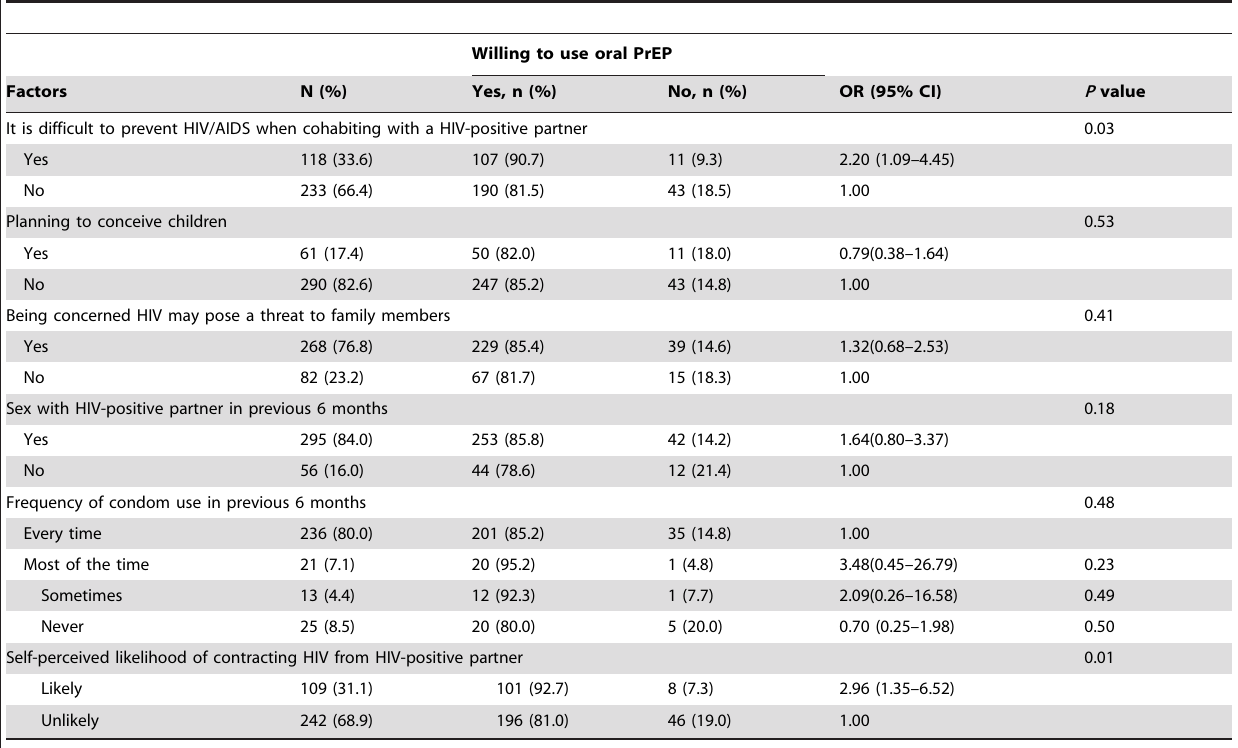
Table 3. Relationship between behaviors/attitudes related to HIV/AIDS and willingness to use oral